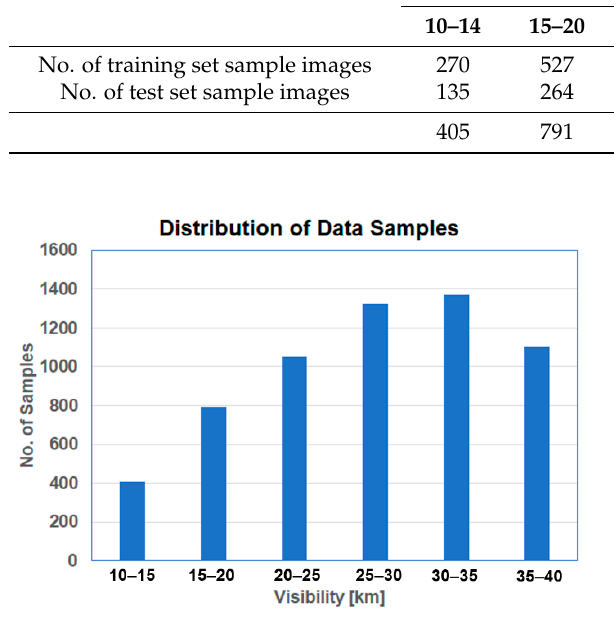
Table 1. Distribution of Visibilities for the image samples.